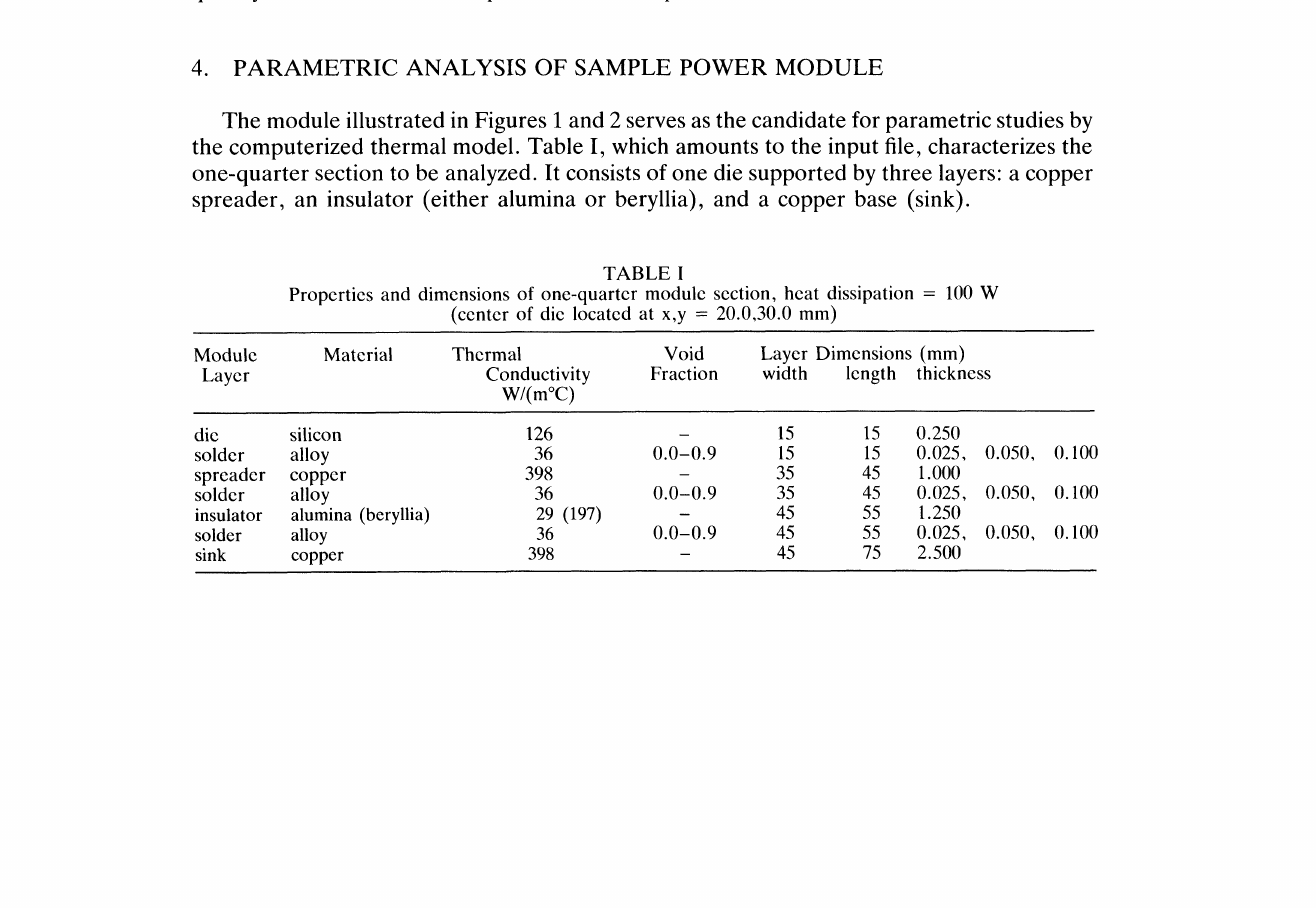
TABLE Properties and dimensions of one-quarter module section, heat